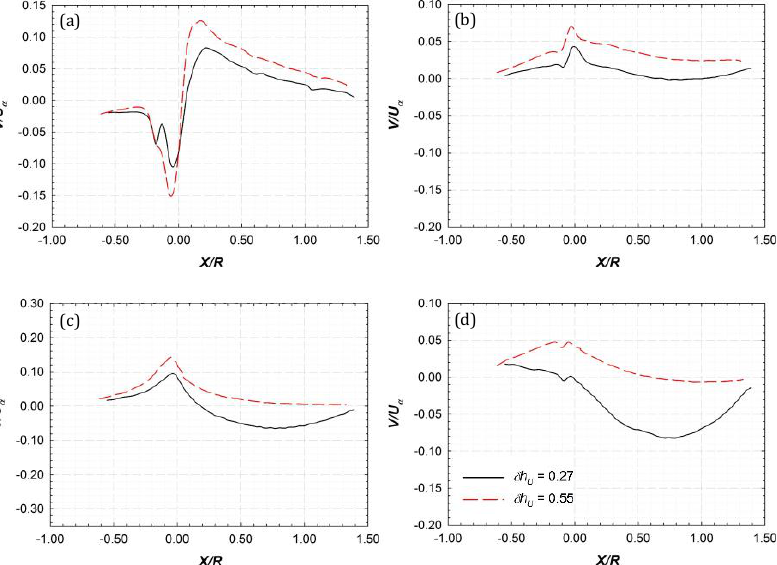
Figure 8. Variations of normalized vertical velocities in the upper-wake bypass region for the rotational velocity of 180 RPM and tip clearance ratios of 0.55 and 0.27 on horizontal lines at depths of ( a ) Y / R = 0, ( b ) Y / R = 0.5, ( c ) Y / R = 1, and ( d ) Y / R = 1.3.